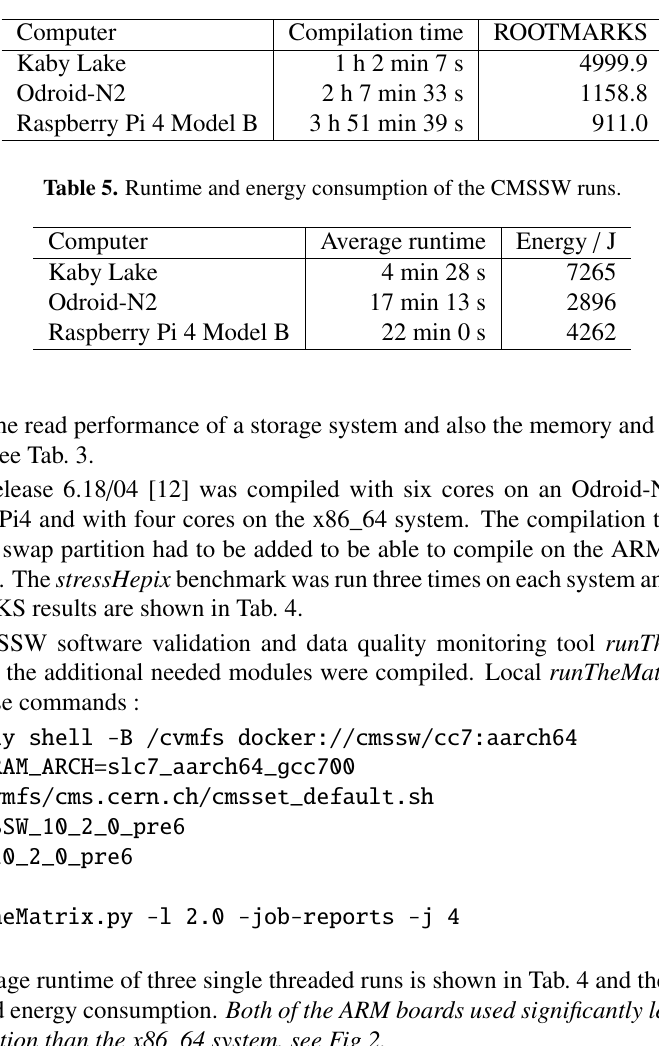
Table 4. ROOT compilation time and ROOTMARKS.